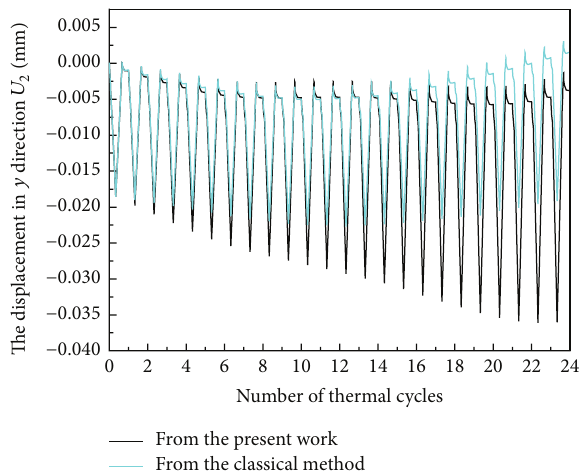
Figure 9: The plot of displacement in 𝑦 direction for number 1 node at the base of the surface groove against the number of thermal